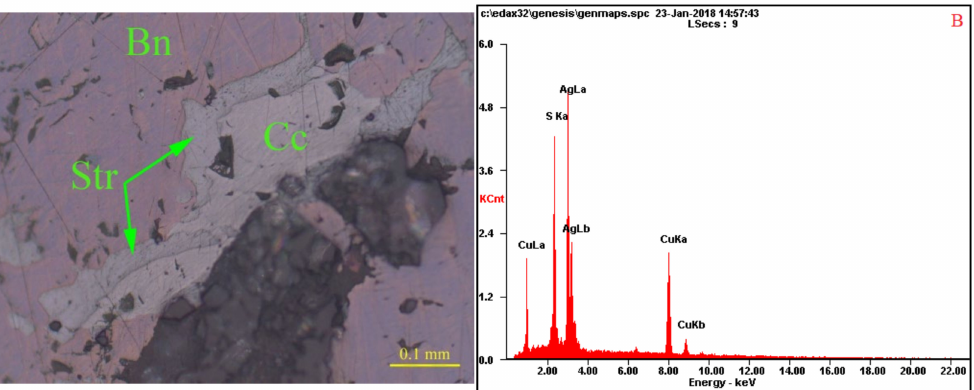
Figure 5. Images and EDS analysis of sphalerite (Gn = galena, Clp = chalcopyrite, Bn = bornite, Po = pyrrhotite, Sp = sphalerite); ( A ) represents the microscope image of the valuable mineral; ( B ) represents the EDS analysis of sphalerite.